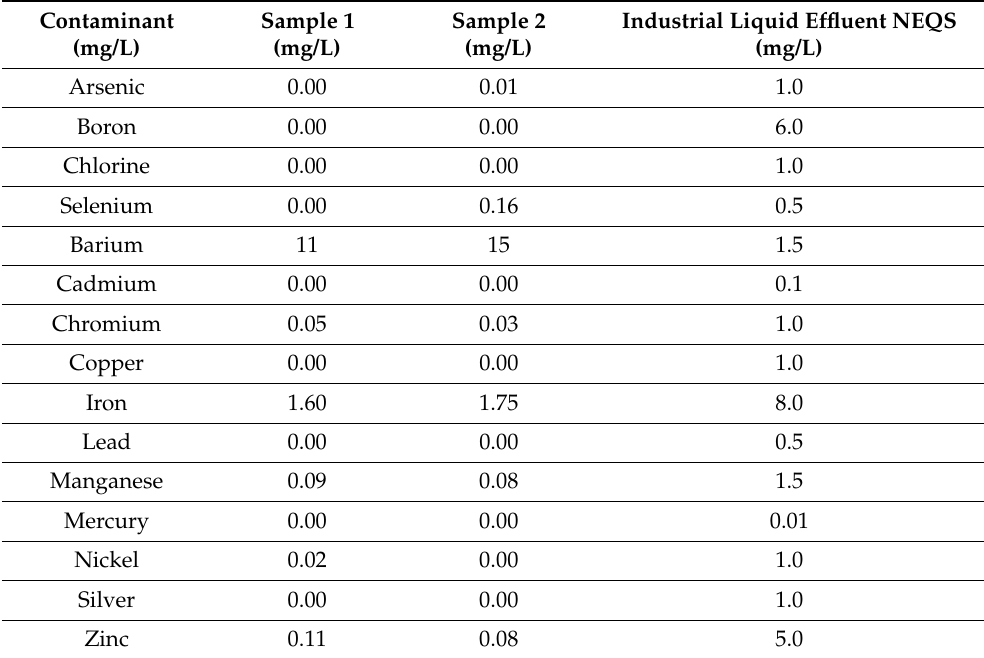
Table 3. Concentration of nonmetals and metals in industrial wastewater samples collected from the study